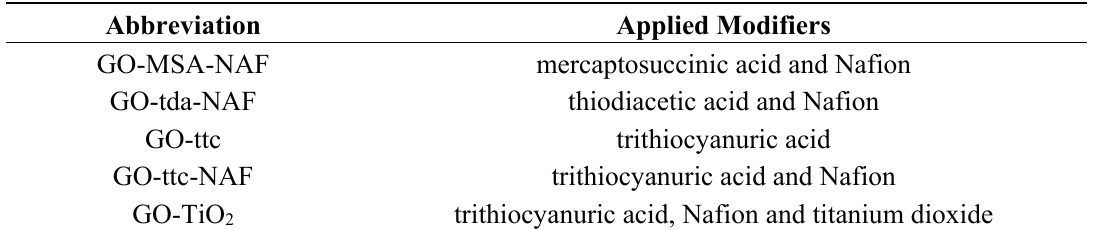
Table 1. Chemical agents used for modification of graphene